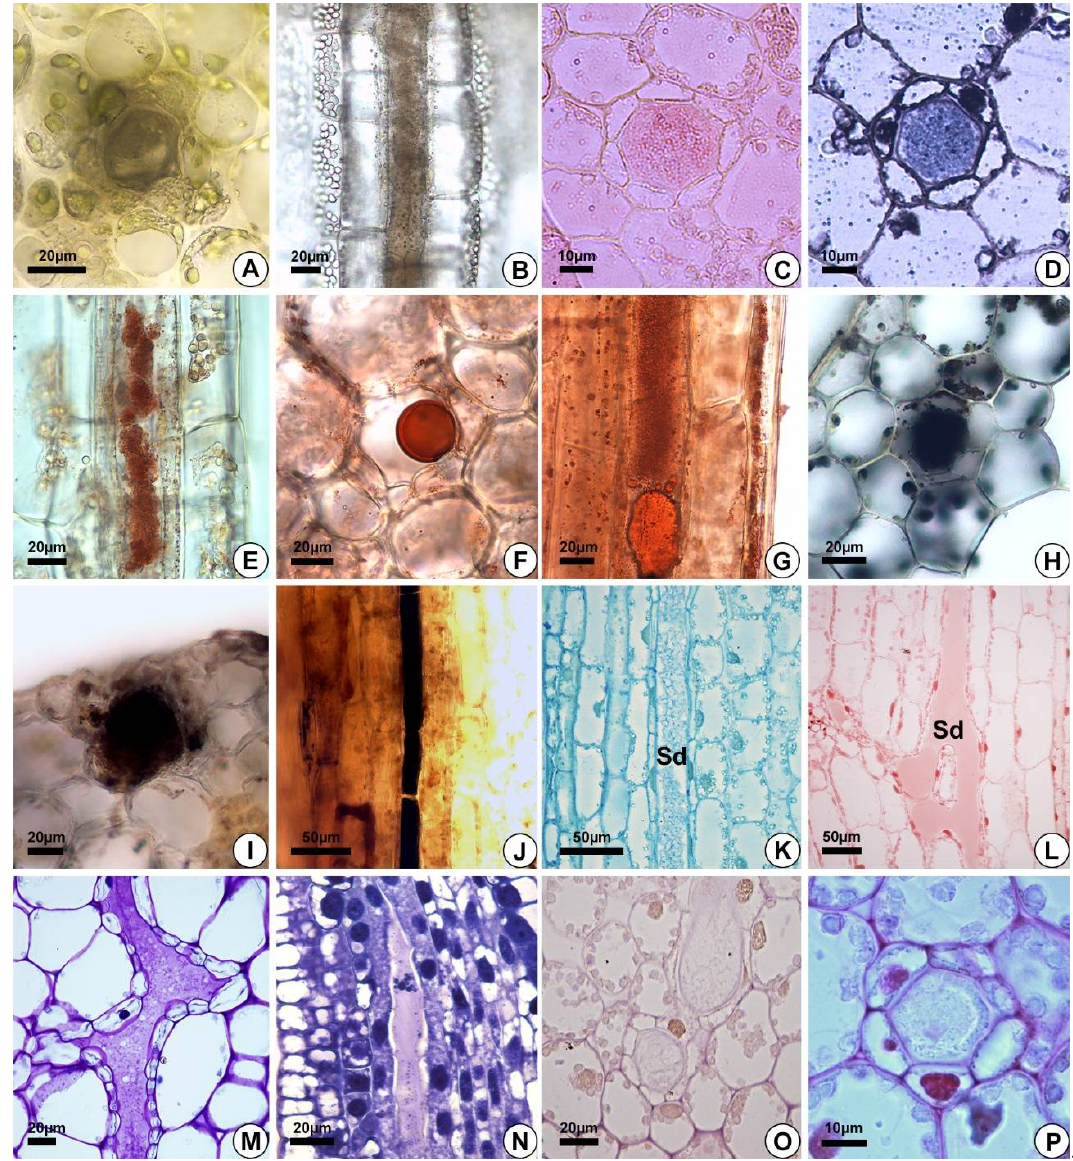
Figure 5. Histochemical analyses of the secretion. ( A , F , G , L , P ) Hydrocleys nymphoides . ( B – E , K , O ) Sagittaria rhombifolia . ( J , N ) Helanthium tenellum. ( I , M ) Limnocharis flava . ( H ) Echinodorus grandiflorus . ( A , B ) Secretory ducts without staining. ( C – G ) Positive reaction of the secretion for total lipids (Sudan IV ( C ), Sudan black ( D ) and oil red ( E – G )). ( H – J ) Alkaloids (Wagner’s reagent). ( K , L ) Proteins (Coomassie blue ( K ) and xylidine Ponceau ( L )). ( M , N ) Secretion with acidic substances (toluidine blue). ( O ) Neutral polysaccharides (PAS). ( P ) Positive reaction of the secretion for acidic mucilage (Ruthenium red). Sd = secretory